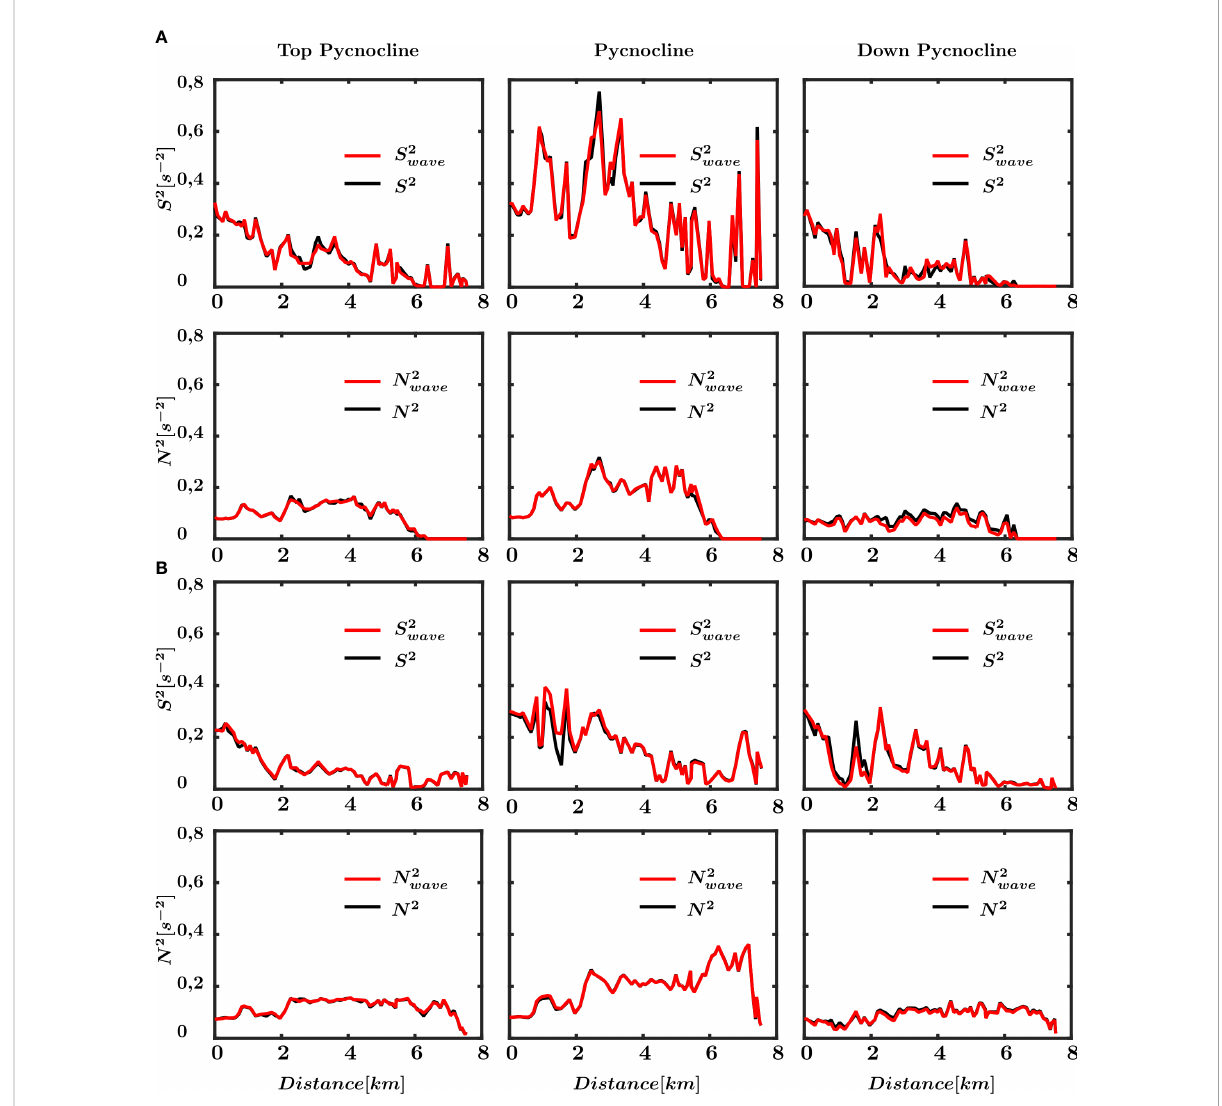
FIGURE 13 Vertical shear stress and buoyancy frequency at the top picnoclyne, middle picnoclyne, and down picnoclyne averaged over a spring tidal cycle, with (red) and without (black) waves, during the dry season of (A) 2018 and (B)